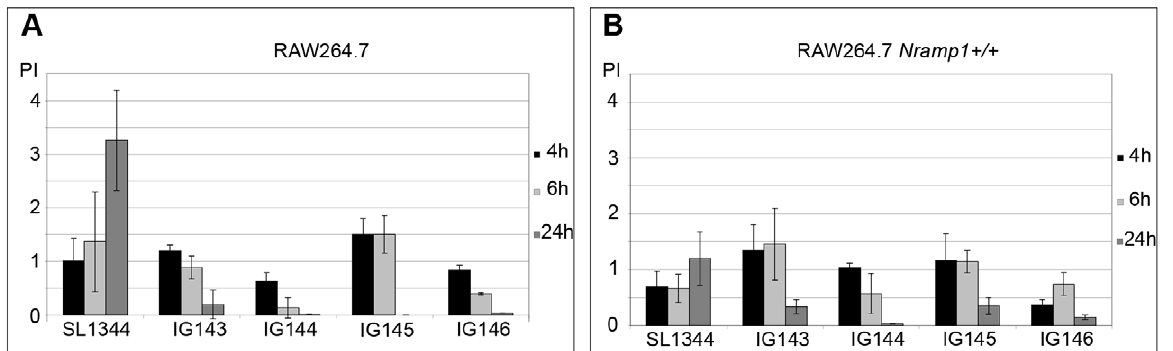
Figure 8. Role of nrdHIEF during macrophage infection. Proliferation indexes (PI) at 4, 6 and 24 h p.i. for wild-type, D nrdAB D nrdR (IG143) and D nrdAB D fur (IG144) double mutant strains and D nrdAB D nrdDG D nrdR (IG145) and D nrdAB D nrdDG D fur (IG146) triple mutant strains infecting ( A ) RAW264.7 and ( B ) RAW264.7 Nramp1 + / + . Results are the mean values of at least three independent experiments. Error bars represent the standard deviation of the mean. Significant differences were determined by Student’s t test for proliferation indexes with P , 0.05.